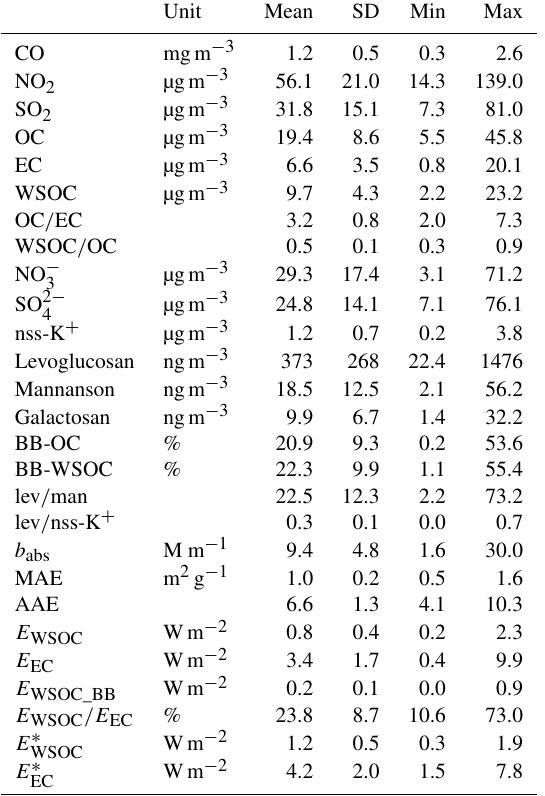
Table 1. Concentration and mass ratio of atmospheric gaseous com- ponents and particulate species (PM 2 . 5 ), biomass burning contribu- tion to carbonaceous aerosol, light-absorption parameters of water- soluble BrC, and solar energy absorption of carbonaceous aerosols.